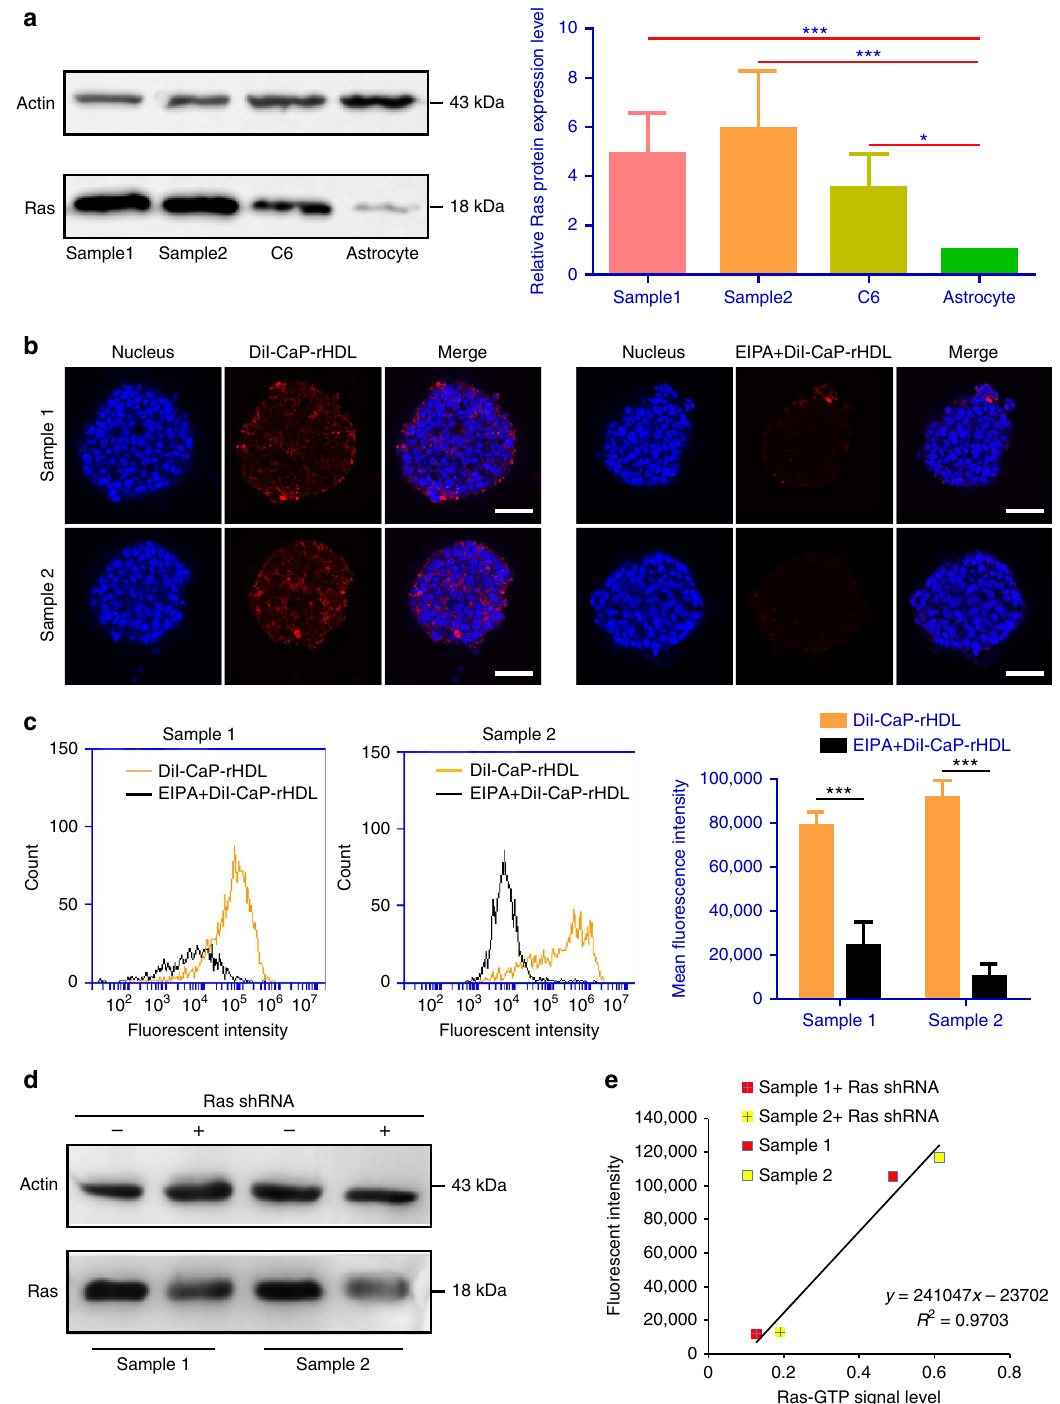
Figure 5 | Patient-derived GICs captured CaP-rHDL in a Ras activity and macropinocytosis-dependent manner. ( a ) Ras-protein level in the GICs derived from two patients (samples 1 and 2), C6 glioblastoma cells and normal astrocytes as determined by a western blot analysis. ( b ) Qualitative and ( c ) quantitative analysis of the cellular uptake of DiI-CaP-rHDL in the GICs derived from two patients after incubation at 37 (cid:2) C for 3h at the concentration of 20 m gml (cid:2) 1 in the absence/presence of EIPA (75 m M). Red: DiI-labelled nanoparticles. Blue: nuclei. Scale bar, 200 m m. ( d ) Western blot analysis confirmed the lower Ras-protein level in GICs after knocking down general all Ras via a shRNA expression lentivirus system. ( e ) A linear regression was established to model the relationship between the cellular uptake of CaP-rHDL and the intracellular Ras-GTP level in GICs ( R 2 ¼ 0.9703). Data represent mean ± s.d. ( n ¼ 3). The significance of the differences between two groups ( *P o 0.05, ***P o 0.001) was evaluated by two-tailed Student’s t negative control siRNA (Cy5-siRNA) as the cargo and indicator. (DSPE-PEG-2000) (Cy5-CaP-LNC-PEG) and is similar with the Cy5-siRNA-loaded CaP-LNC which contains 1,2-distearoryl-sn- nanoparticles which have shown good in vivo behaviour glycero-3-phosphoethanolamine-N-poly(ethylene glycol) 2000 and RNAi effect 19 , was here used as the control formulation.